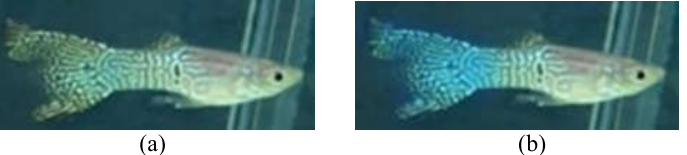
Figure 5. With random discoloration to improve data diversity: ( a ) before dyeing and ( b ) after dyeing.